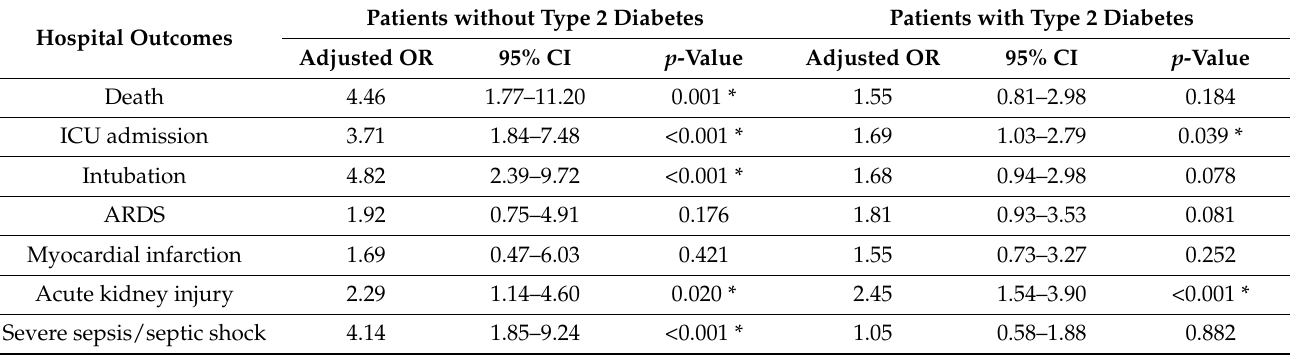
Table 3. Adjusted association between admission blood glucose >200 mg/dL and hospital outcomes in patients with and without type 2